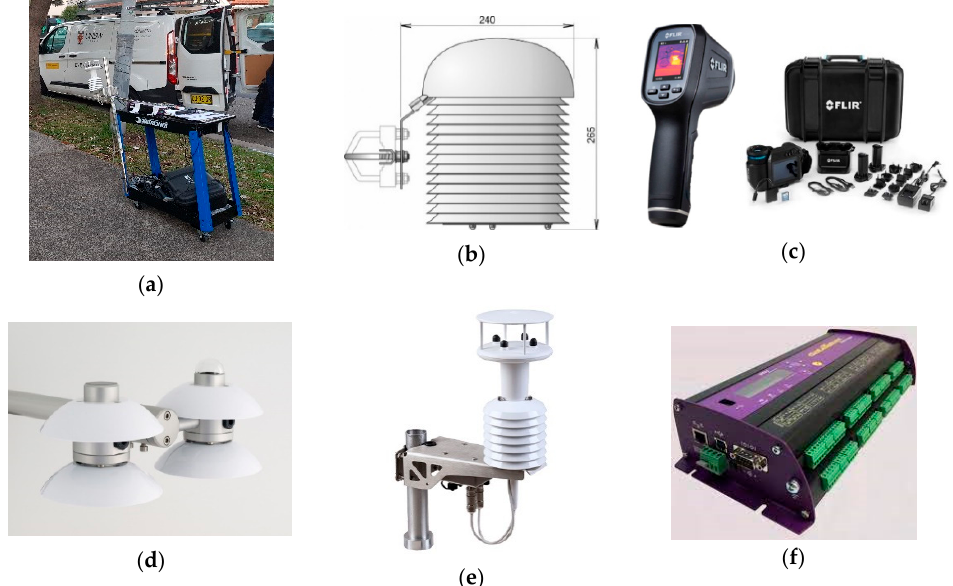
Figure 2. The MetPak Pro weather station mounted cart used for spot measurements in tracks on the left and a white radiation shield TG54 infrared thermometers integrated on the cart, respectively in the middle and on the right. ( a ) MetPak Pro weather station ( b ) White radiation shield ( c ) T540 by